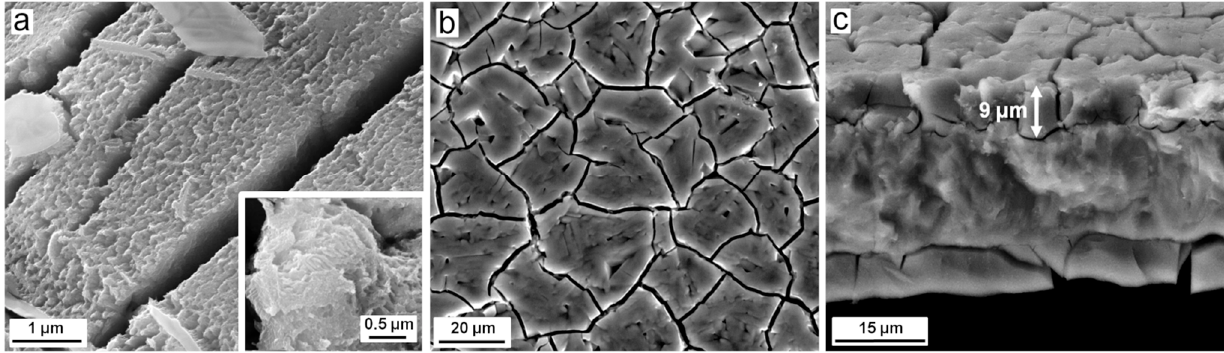
Figure 4. SEM images of ( a ) surface view of SS_KOH, ( b ) surface view of SS_HF and ( c ) cross-sectional view.